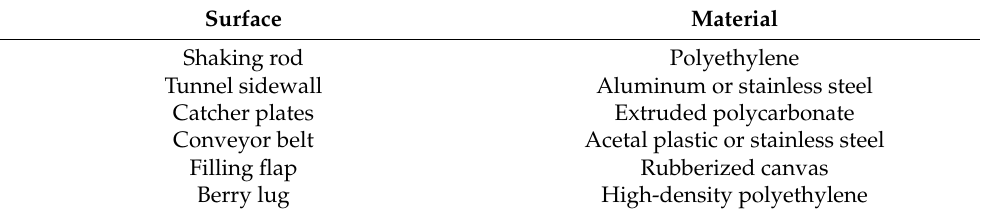
Table 1. Composition of blueberry mechanical harvester fruit contact surfaces assessed in this